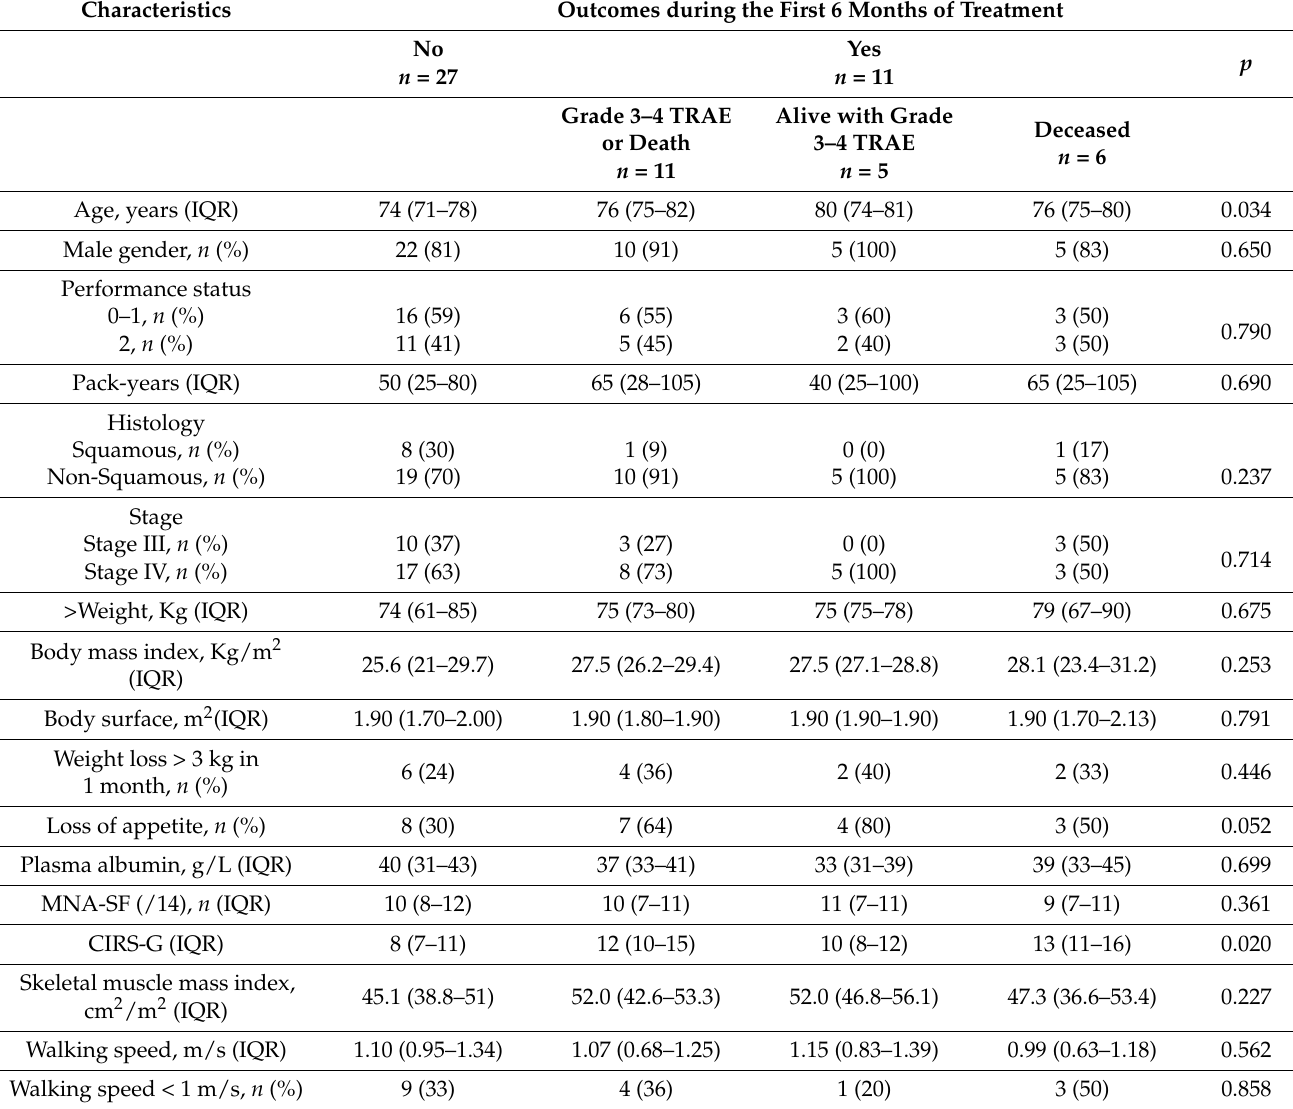
Table 2. Characteristics at inclusion according to occurrence of Grade 3–4 TRAEs or early